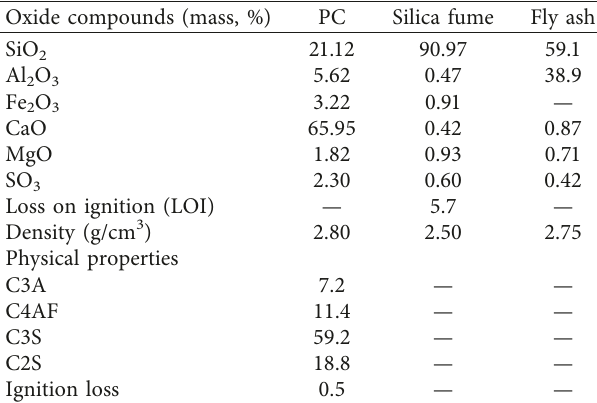
Table 1: Chemical composition of cement and supplementary cementing materials.